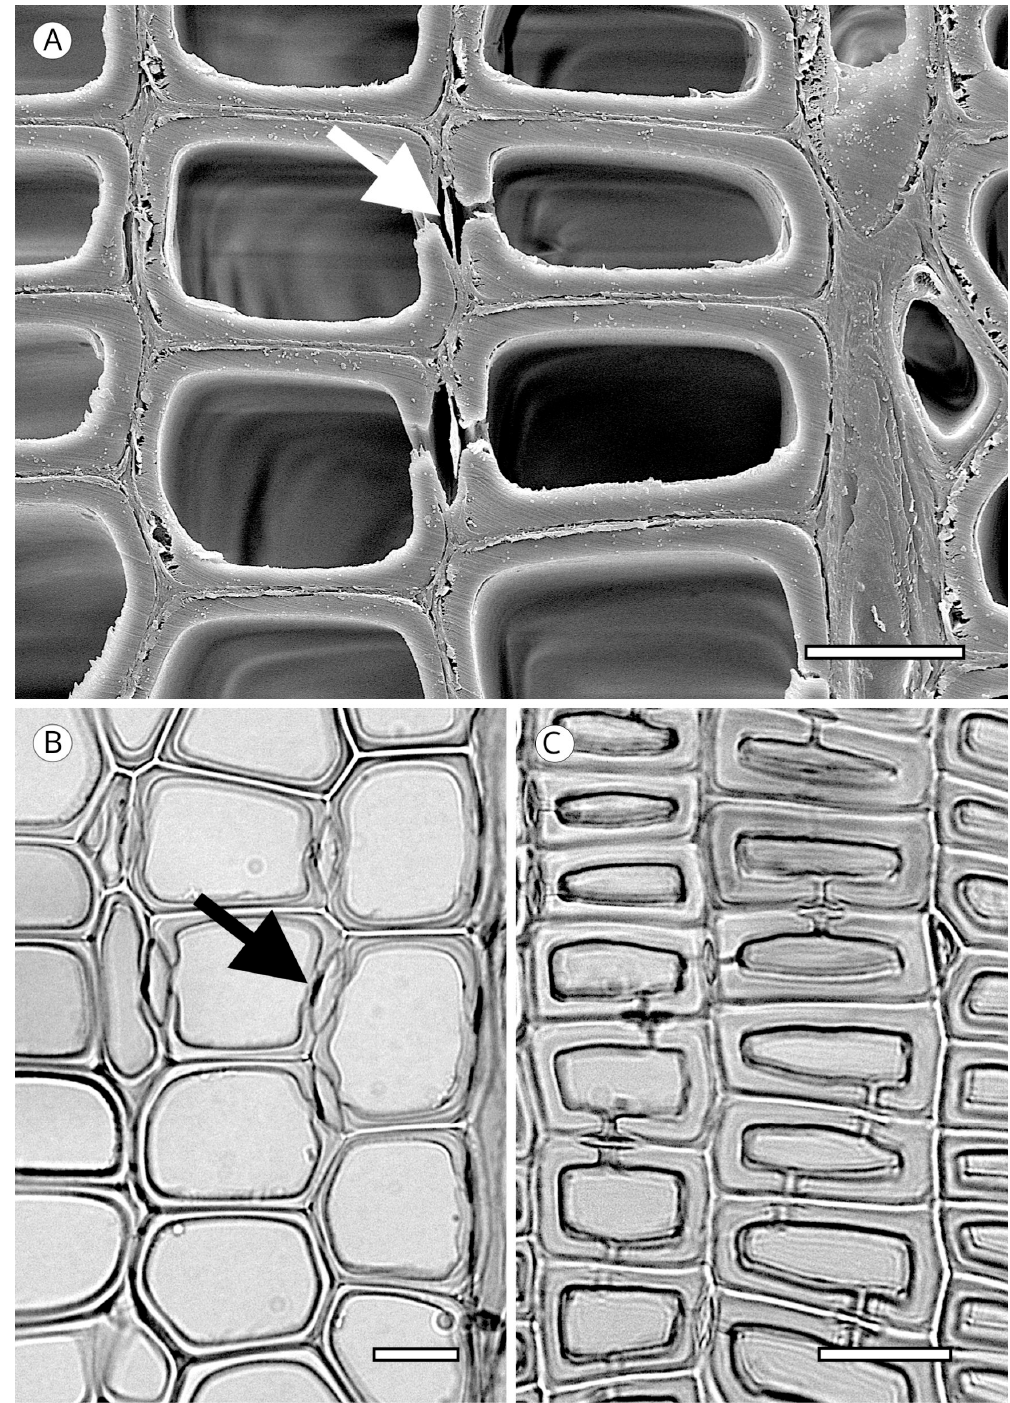
Figure 14. Torus. ( A ) Torus defined in Chamaecyparis formosensis Matsum. (SEM); ( B ) Torus defined in Cupressus cashmeriana Royle ex Carrière; ( C ) Torus not defined in Thuja plicata Donn ex D.Don. Scale bars. ( A – C ) = 25 μ m.